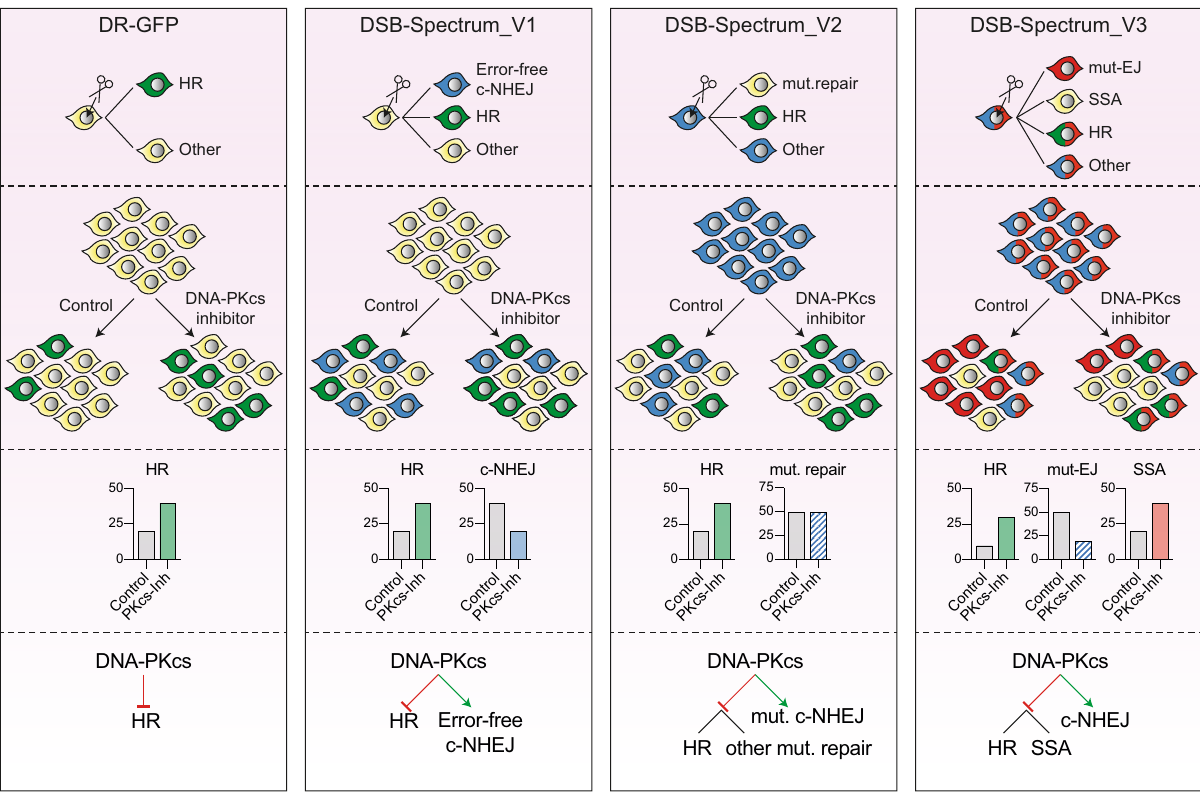
fl uorescence changes caused by repair of the site-speci fi c DSB in the depicted reporterconstruct,(2)acartoonexampleof apopulationafterreporteractivation, in presence or absence of DNA-PKcs inhibition as an example of a DSB-repair manipulationstrategy,(3)quanti fi cationoftheresultsinpanel2,and(4)themodel resulting from the data obtained with the reporter